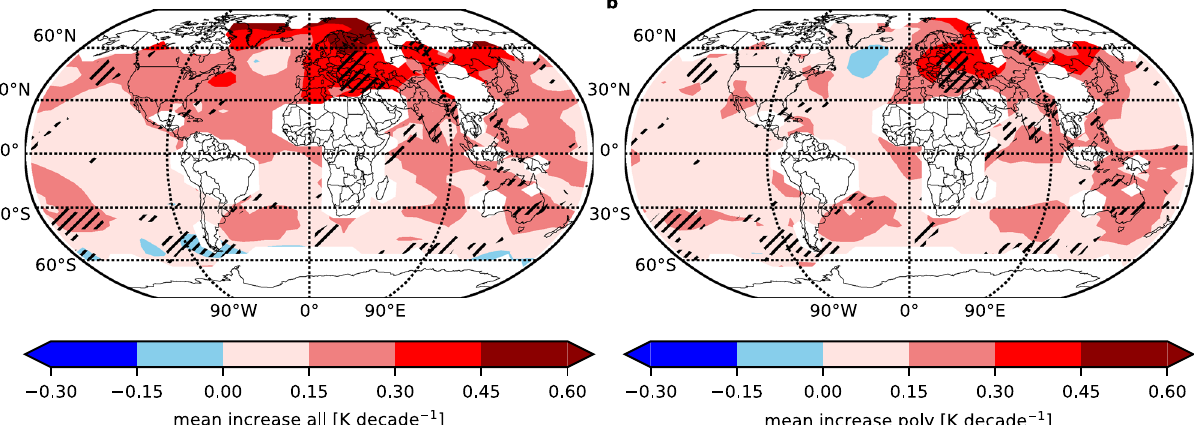
Figure 4. Difference between observed total temperature increase and approximative anthropogenic part. ( a ), ( b ) Global distributions of the mean temperature increase from the time interval 1971–1980 to 2009–2018 for the full increase ( a ) and the polynomial only ( b ), which approximatively shows the anthropogenic part. Only results for average values with full temporal coverage for all single data points have been considered. White areas show regions, where not enough or no data are available. The hatched areas mark region where the data were fitted